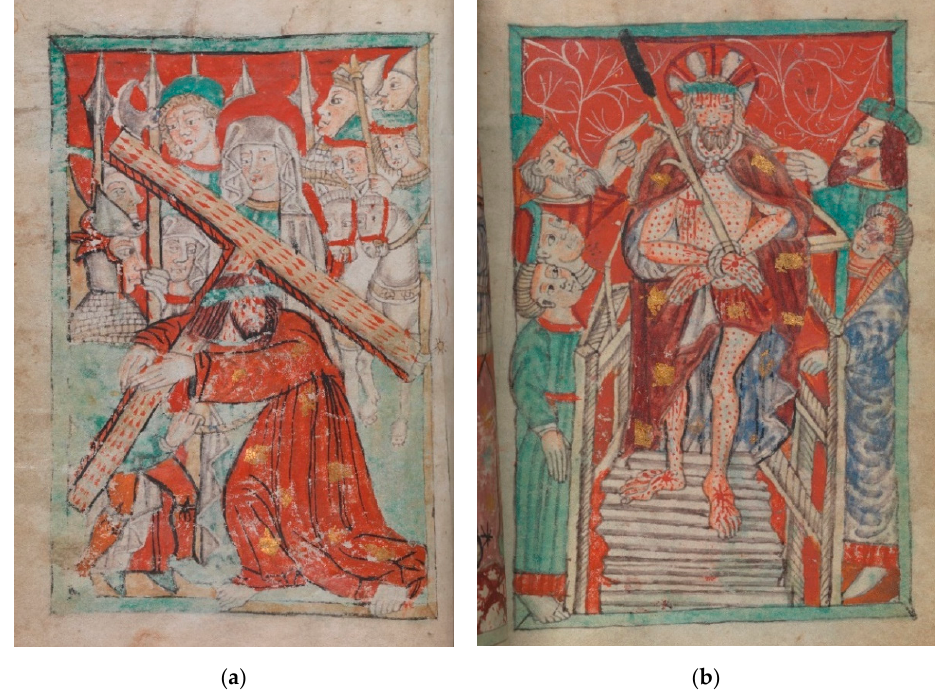
Figure 23. ( a ) Seanchas Burcach ( History of the Burkes ), Dublin, Trinity College MS 1440, c.1570, Christ carrying the cross, f.18v, ( b ) Man of Sorrows, f.18r. Reproduced by permission of the Board of Trinity College, the University of Dublin. Devotion to the five wounds of Christ emerged in Ireland at least as early as the late thirteenth century. A tomb in St Canice’s Cathedral, Co. Kilkenny, believed to be that of